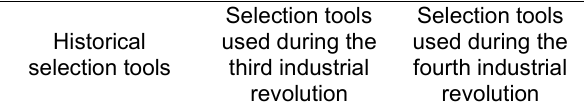
selection tools